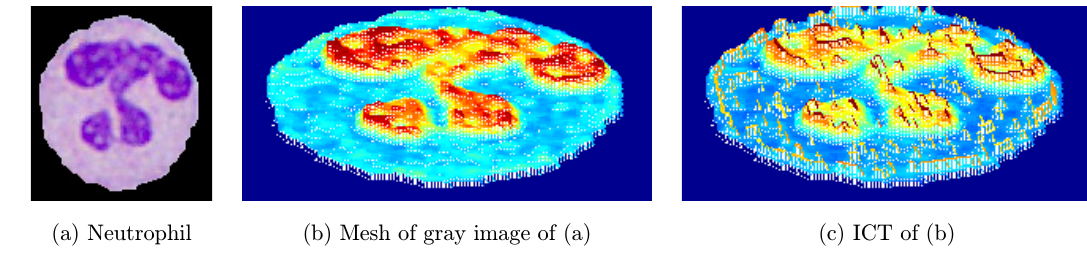
Fig. 4. Clustering of neutrophil.